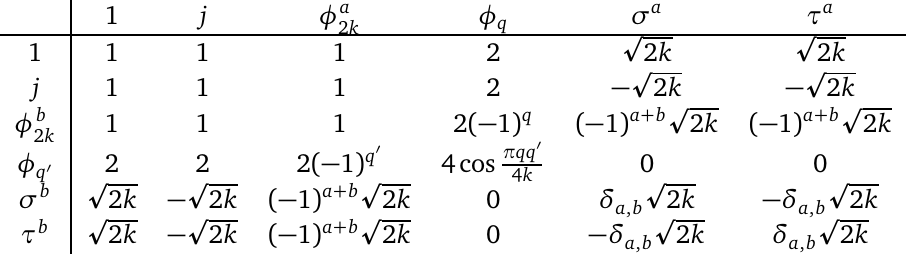
Table 4: Modular S matrix for Pin + ( 2 ) are a , b = 1,2, q , q (cid:48) = 1, ··· 2 k −